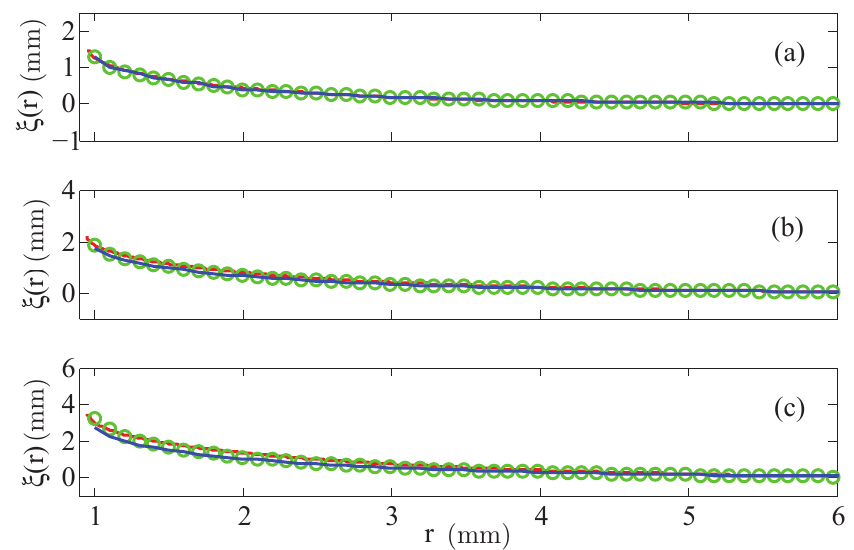
Figure 9. Calculated menisci of the magnetic fluid APG S21 for a nonlinear law ( ) and linear law of magnetisation with χ = 0.65 ( ◦ ) versus the experimentally determined surfaces ( ). ( a ) H = 3.35 kA/m, ( b ) H = 7.54 kA/m and ( c ) H = 11.73 kA/m at R = 0.95 mm.